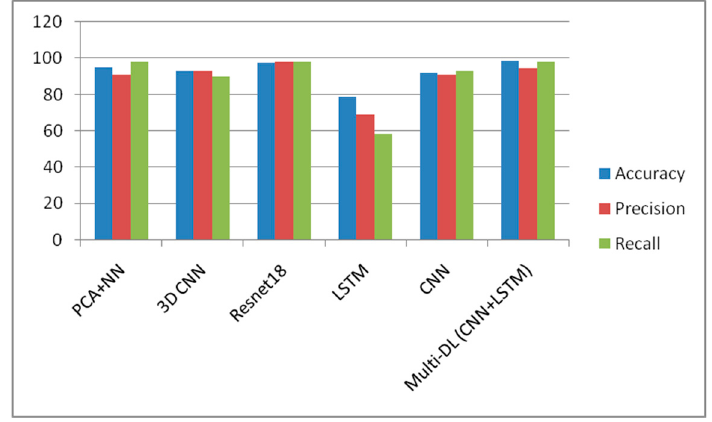
Figure 11. Accuracy comparison chart for various methods showing a better performance in the proposed CNN, LSTM combination.